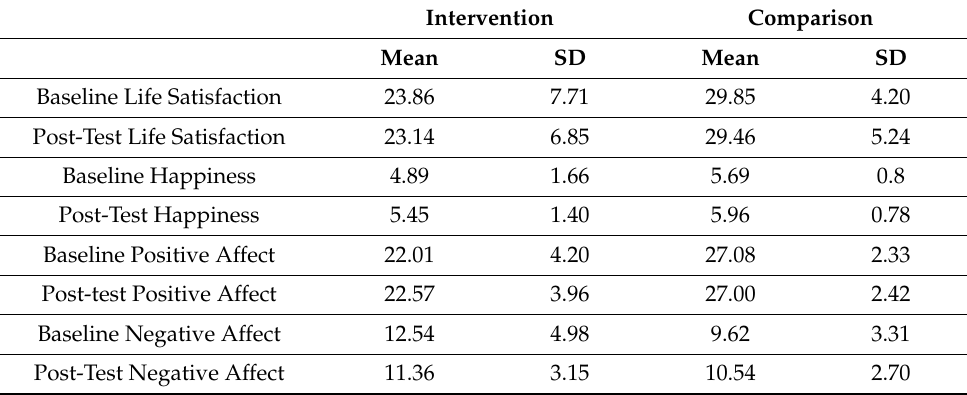
Table 3. Baseline and post-test scores of psychological well-being by group.